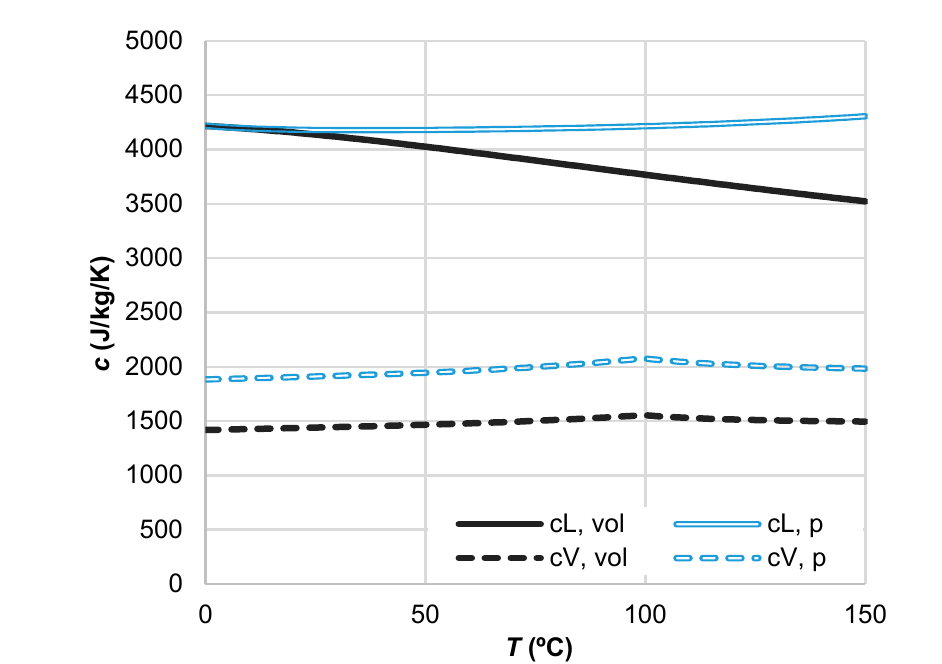
Figure 5. Specific heat capacity c of liquid (L, solid lines) water and water vapour (V, dashed lines) for the temperature range 0–150 ◦ C, at the minimum between saturation pressure and 100 kPa, for isochoric (vol, black) and isobaric (p, blue outline) conditions. All values from the NIST [13]. The temperature (and pressure) conditions corresponding to the specific heat capacity values used for modelling are not always reported in the literature. Then, a comparison of the literature and reference values is useful to identify such conditions and assess their consistency with the modelling conditions. The literature values in Table 2 are consistent with the reference values represented in Figure 5. The two values used for liquid water (4180 and 4202 J/kg/K) correspond to the reference specific heat capacities at 30 and 7 ◦ C, respectively, for isobaric conditions, and at 13 and 6 ◦ C, respectively, for isochoric conditions. The values used for water vapour in isobaric conditions (between 1870